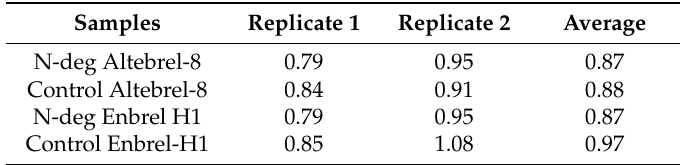
Table 5. Potency ratio of the etanercept samples to the in-house